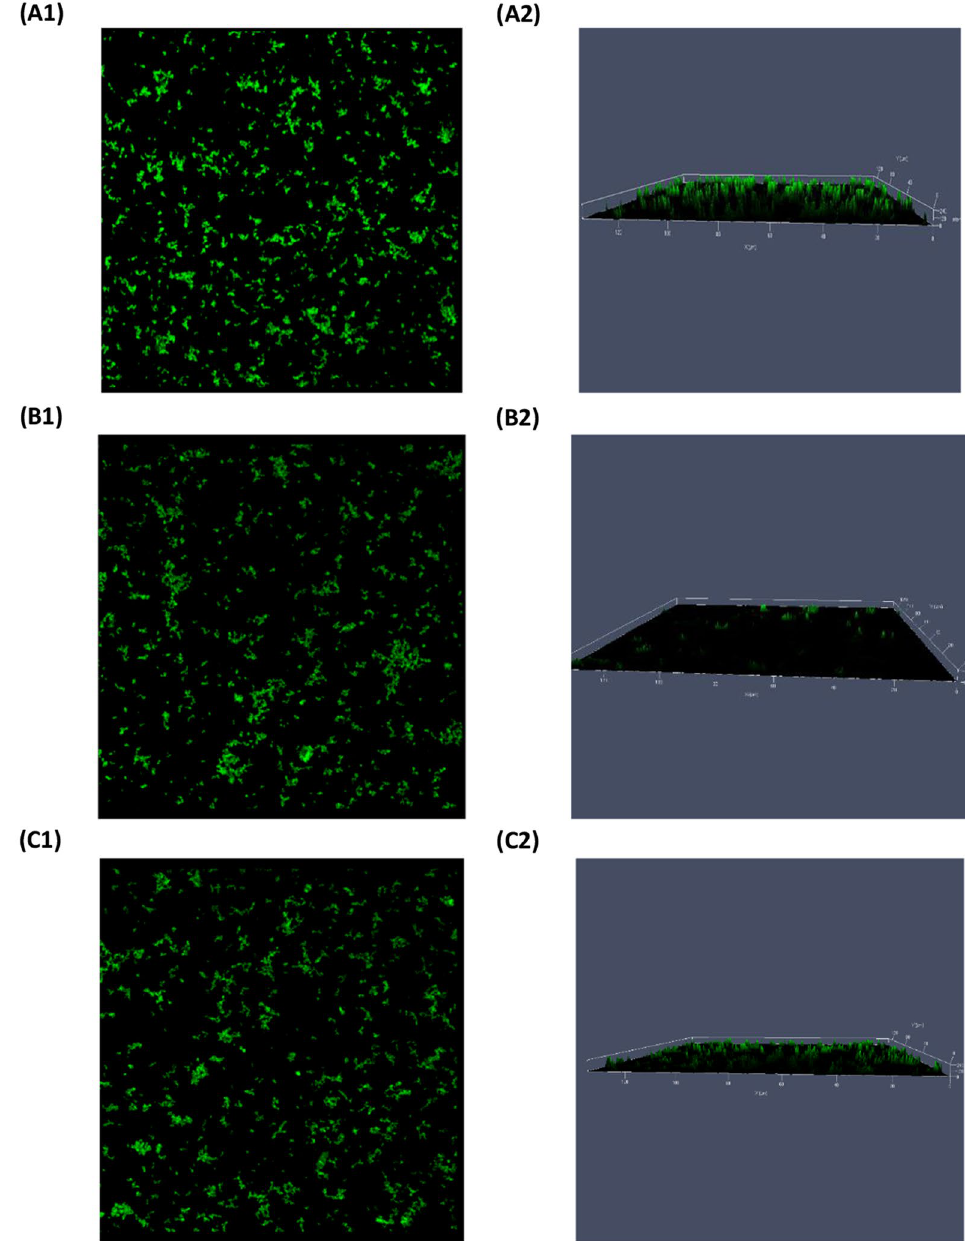
Fig. 6 CLSM images of ConA‑FITC ‑stained biofilms obtained after 24 h growth of P. aeruginosa. (1) refers to the two‑dimensional (2D), and (2) refers to the 2.5D view of A untreated P. aeruginosa. B micafungin 100 µg/mL treated P. aeruginosa. C azithromycin 8 µg/mL treated P.